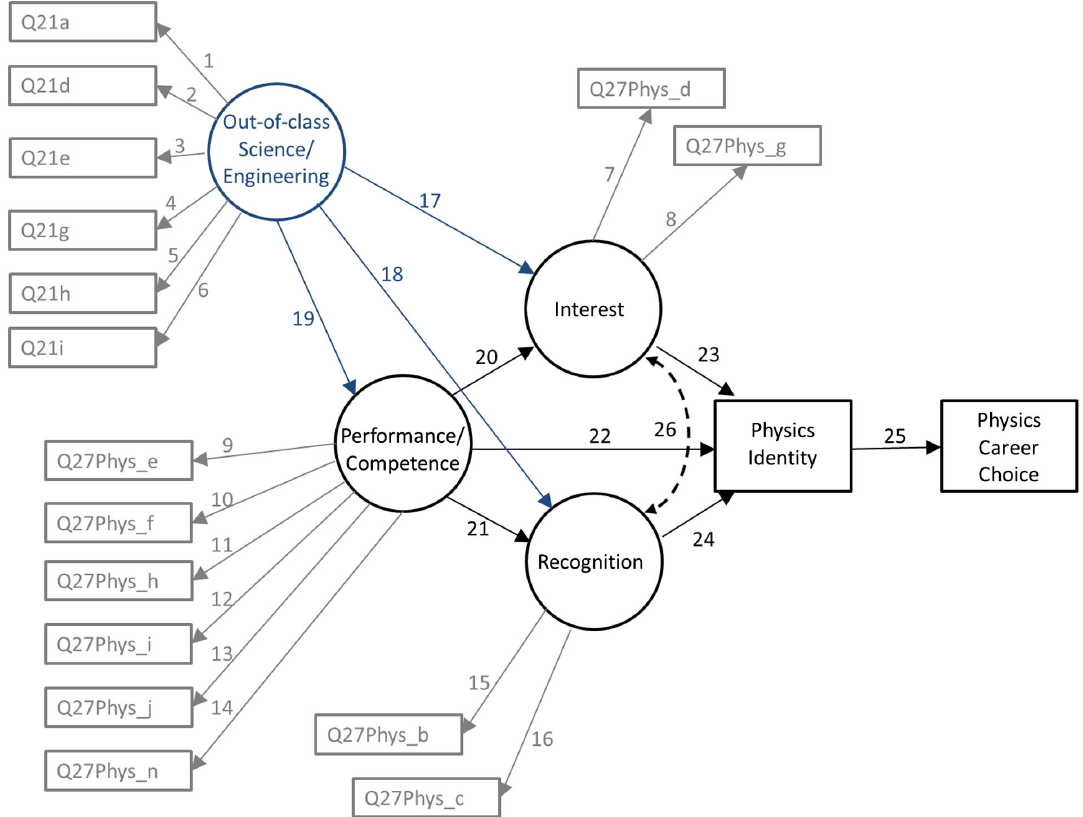
FIG. 2. Structural equation model of the relationships between the identity dimensions, physics career choice, and out-of-class science and engineering activities. Boxes indicate survey items, and circles represent latent variables